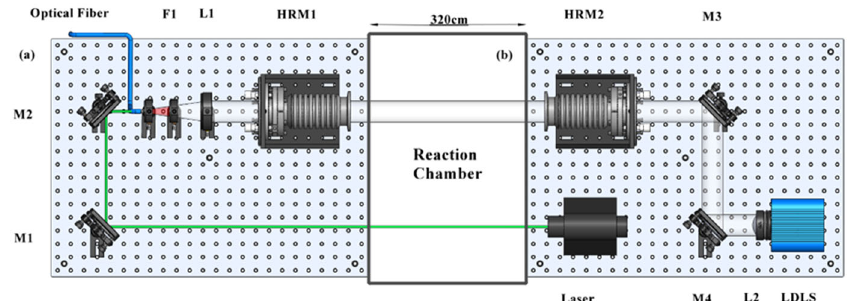
Figure 1. Schematic layout of the OP-IBBCEAS system and atmospheric simulation chamber (center). (a) The receiver platform. (b) The transmitter platform. These two platforms are installed on both sides of the chamber. M1 to M4 are beam steering mirrors. The high reflectivity mirrors HRM1 and HRM2 were mounted on the frames. F1 is an optical filter. L1 and L2 are the focus lenses. The high-reflectivity (HR) optical cavity mirrors (Layertec Gmbh) were 50 mm in diameter and had a 7 m radius of curvature. The reflectivity of the HR mirrors is greater than 0.999 from 620 to 670 nm reported by the manufacturer. The transmitted cavity light was focused by a plano-convex lens ( f = 60 cm), filtered by a band-pass filter (FF02-675/67-25, Semrock, NY, USA), and coupled into a 100 µ m-diameter optical fibre. The fibre was connected to a monochromator (Andor Kymera-328i-A, Andor Tech., Oxford Instruments, Oxford, UK) coupled with a CCD detector (Andor DU420A-BU, Andor Tech., Oxford instruments, Oxford, UK). The monochromator uses 600 l mm − 1 diffraction grating (500 nm blaze) and covered a wavelength range between 600 and 724 nm. The spectrometer resolution was determined by fitting the emission line of the mercury argon calibration light source (Hg-1, Ocean Optics) at 692.95 nm, corresponding to 0.54 nm. In order to minimize the dark current, the CCD detector was regulated and stabilized at − 60.0 ◦ C. For measurements at SAES, the transmitter unit and the receiver unit were installed on both sides of the cylindrical SAES-ARC chamber, giving a mirror separation d of 3.65 ± 0.04 m.